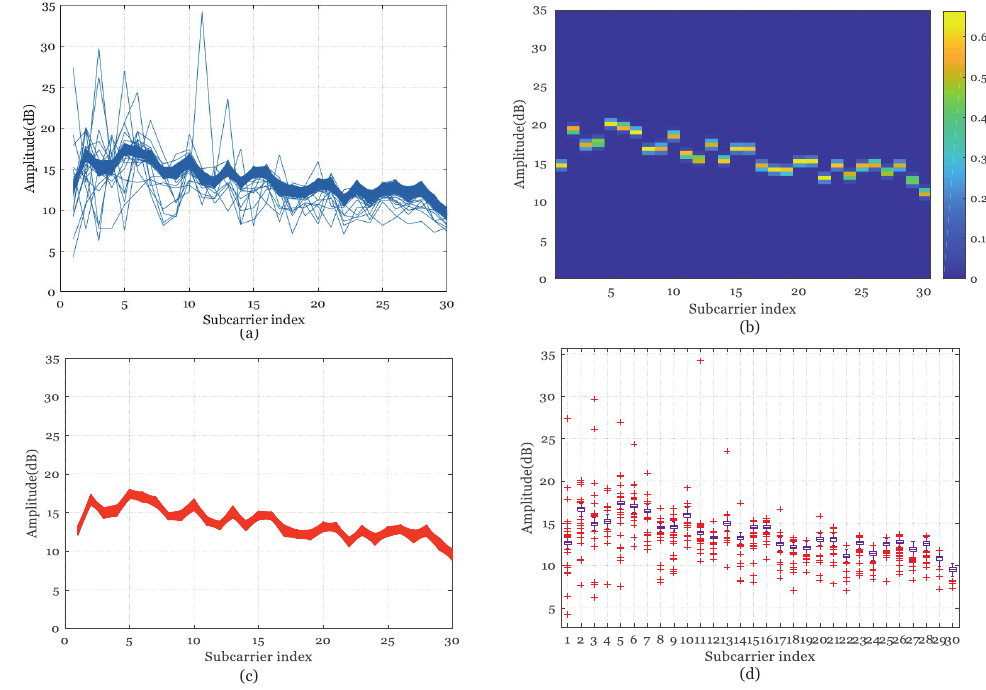
Figure 2. CSI amplitude outlier filtering processing at position 2 in scenario 2 (Single laboratory). ( a ) The Raw CSI amplitude. ( b ) The distribution heat map of the amplitude probability. ( c ) The Processed CSI amplitude. ( d ) The boxplot diagram of raw CSI amplitude.